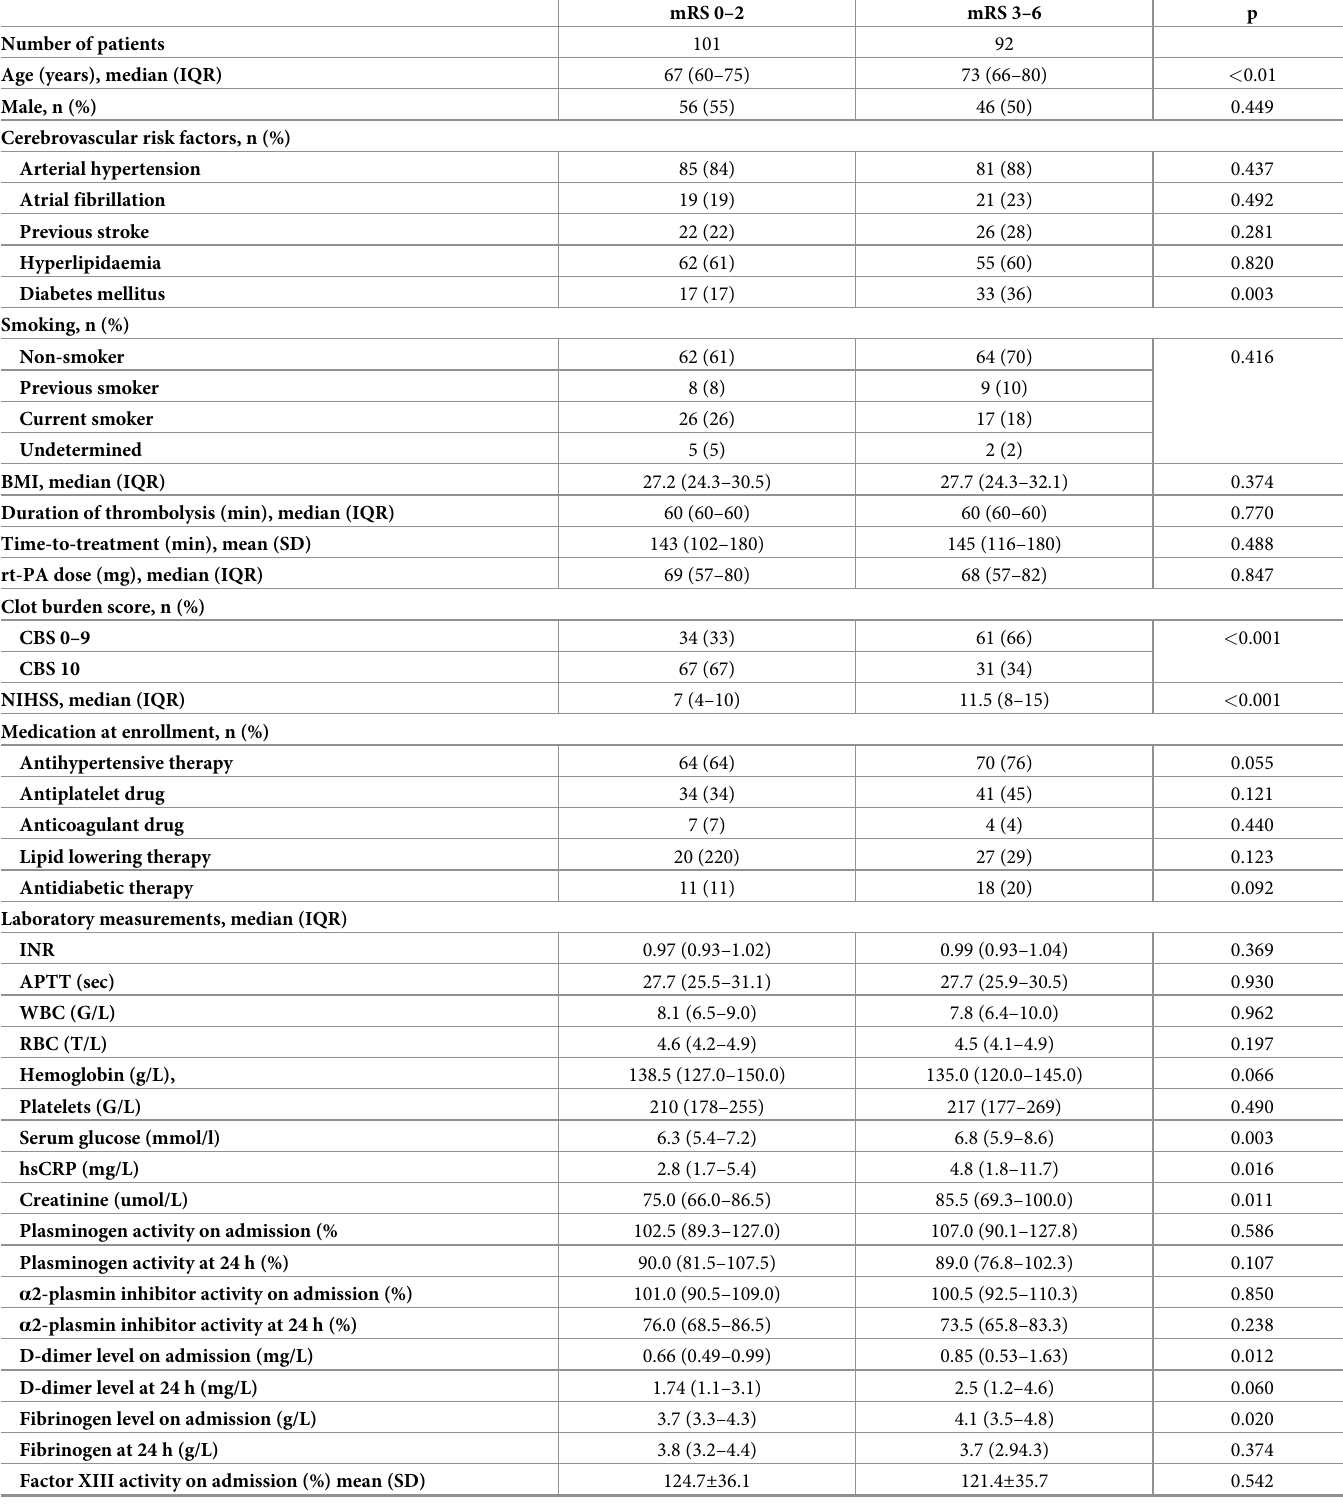
Table 4. Baseline parameters and specific hemostasis markers according to long-term functional outcomes in the studied